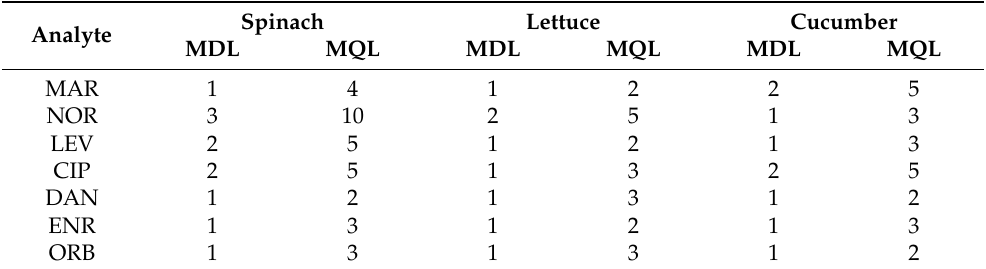
Table 2. MDL and MQL values (ng g − 1 ) obtained for each analyte from matrix-matched calibration curves, taking into consideration the whole sample